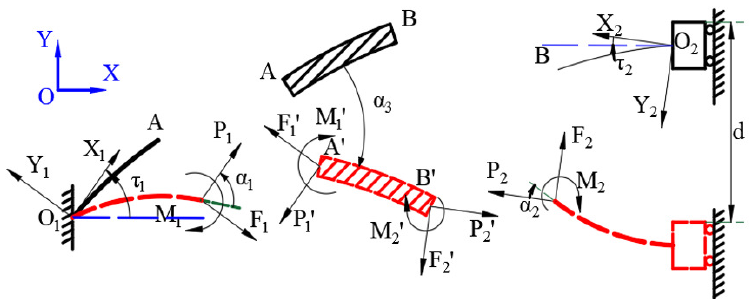
Figure 8. Free body diagram of circular-beam bistable limb in proposed